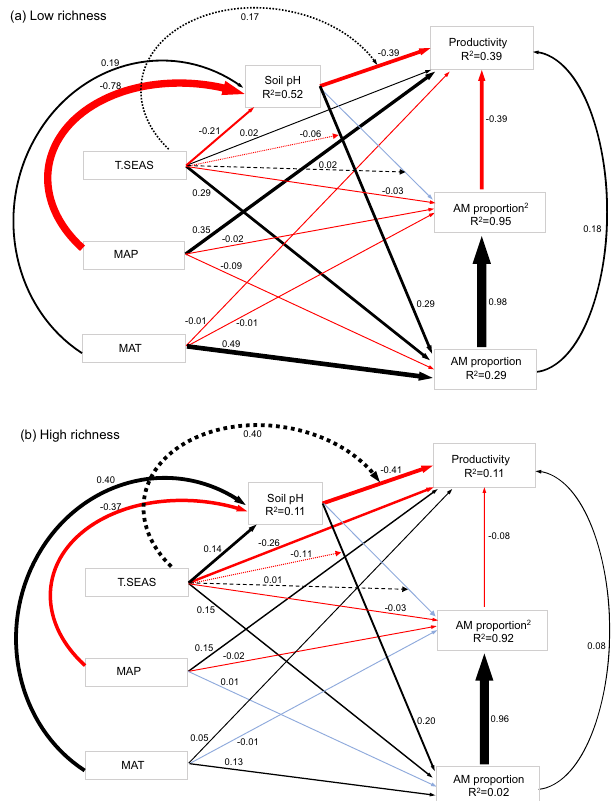
Fig. 5 | Structural equation models of climate, soil pH, and AM proportion as predictors of forest productivity. a Forests with low tree species richness (rich- ness ≤ 5). b Forestswithhightreespeciesrichness(richness>5).Solidblackarrows represent positive paths ( p <0.05, piecewise SEM), solid red arrows represent negative paths ( p <0.05, piecewise SEM), and solid blue arrows represent non- signi fi cant paths ( p >0.05,piecewiseSEM).Inaddition, we included the interactive effectsofT.SEASandsoilpHonAMproportionandproductivity,withdashedblack and red arrows representing positive and negative effects, respectively. We report the path coef fi cients as standardized effect sizes. Overall fi t of piecewise SEM was evaluatedusingShipley ’ stestofd-separation:Fisher ’ sC=3.466& p =0.177forlow- richnessforests;Fisher ’ sC=5.206& p =0.074forhigh-richnessforests(if p >0.05, then no paths are missing and the model is a good fi t). AM proportion 2 , quadratic AM proportion; MAT, mean annual temperature; MAP, mean annual precipitation; T.SEAS, temperature seasonality. Note that the arrows from AM proportion to AM proportion 2 re fl ect deterministic relations based on a calculation rather than hypothesized causal